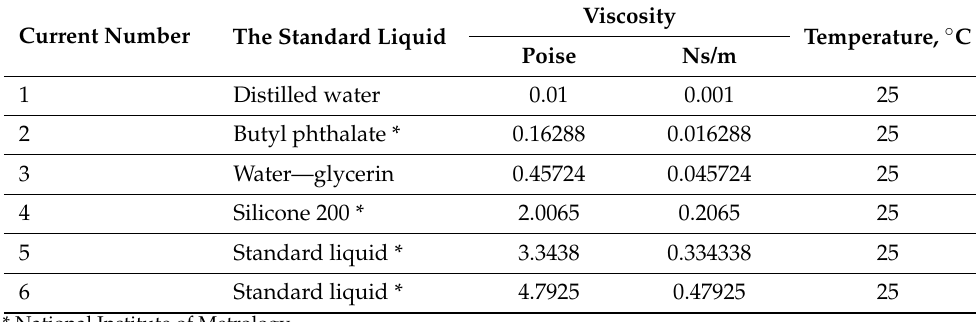
Table 1. Viscosity of some standard liquids.